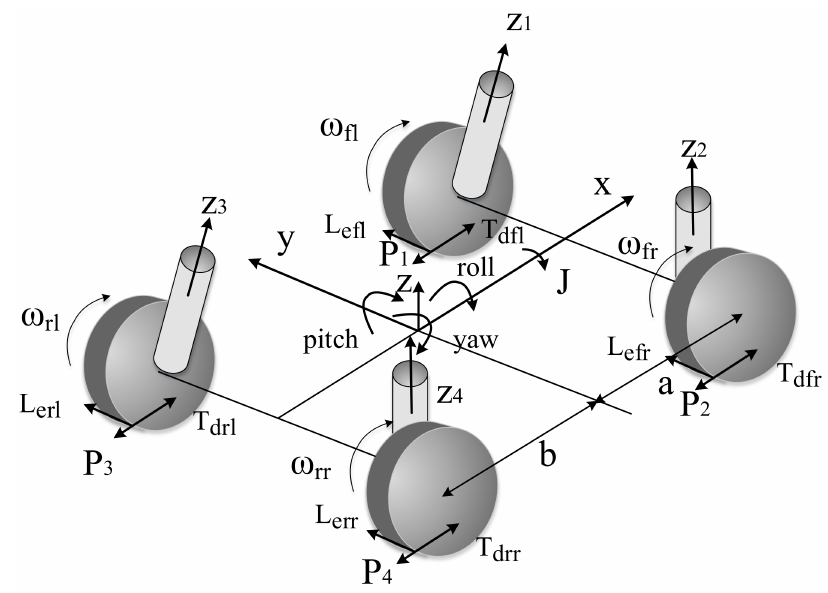
Figure 2. The 27-DOF